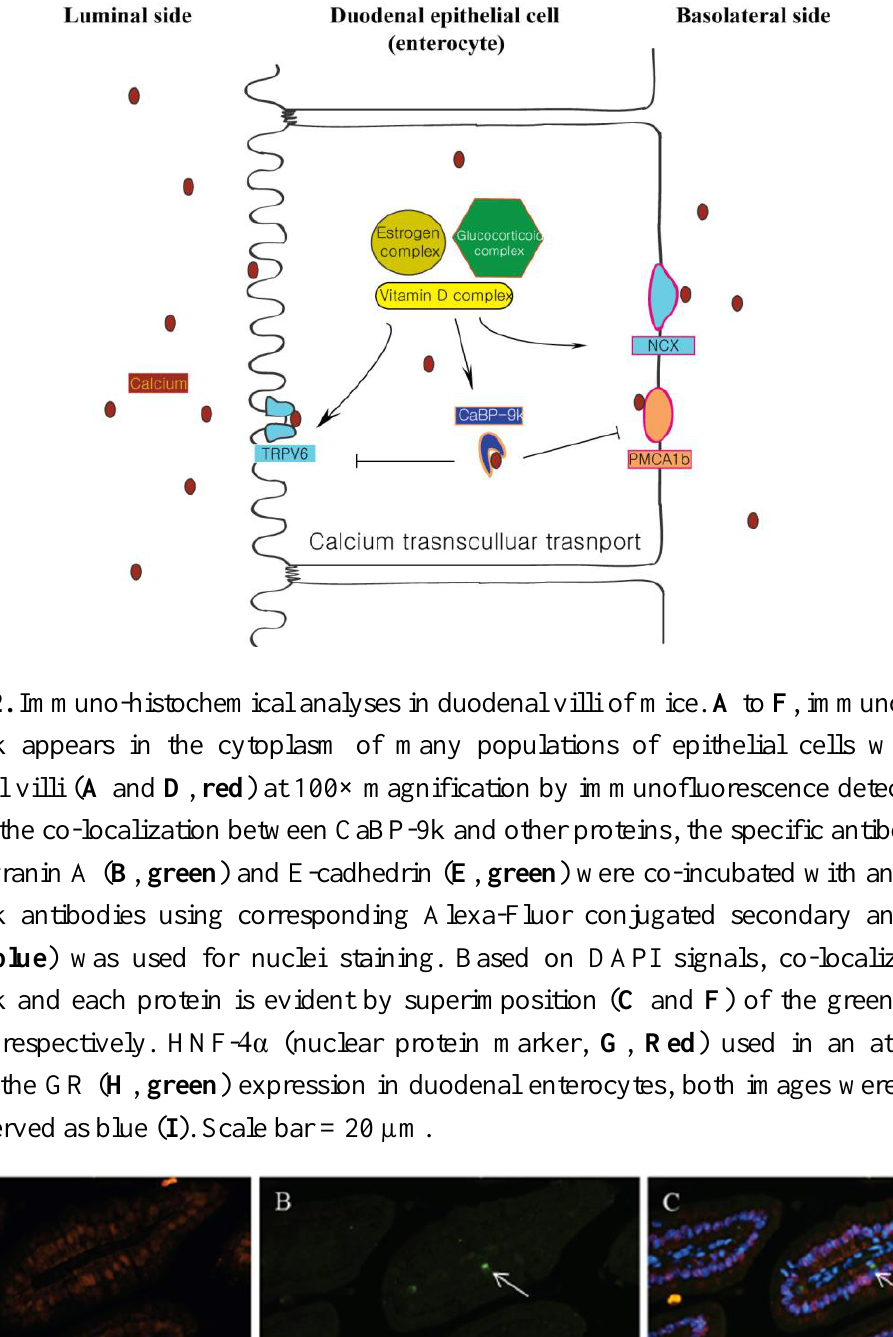
Figure 1. CaBP-9k of transcellular calcium transport in duodenal enterocyte. In the transportation, calcium binds to membrane bound TRPV6, which influxes from the extracellular environment. The calcium translocates into the cytoplasm and binds to calcium binding protein CaBP-9k. The calcium-bound CaBP-9k may also move to the basolateral side and transfer its bound calcium to PMCA1b or NCX channel protein, leading to uptake into serum.